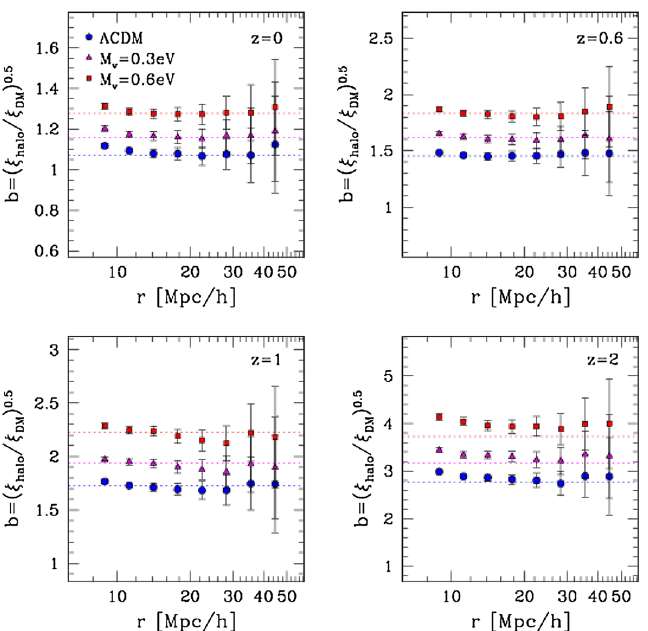
Fig. 45 Bias of the DM haloes in the Λ CDM N -body simulation (blue circles) and in the two simulations with Σ = 0 . 3 eV (magenta triangles) and Σ = 0 . 6 eV (red squares). Dotted lines are the theoretical predictions of Sheth et al.